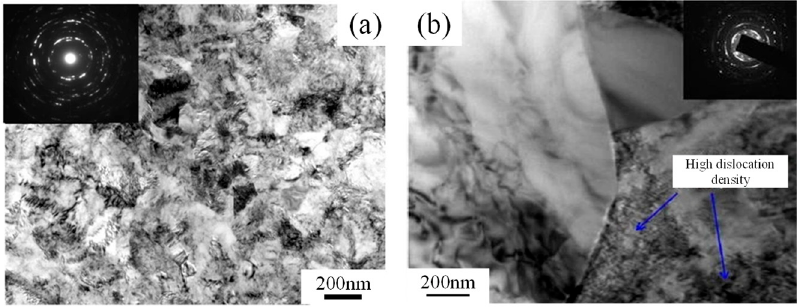
Figure 3. TEM image of the material after four passes: ( a ) titanium alloy [32]. Reproduced with permission from MDPI. ( b ) magnesium alloy [36]. Reproduced with permission from Springer Nature.